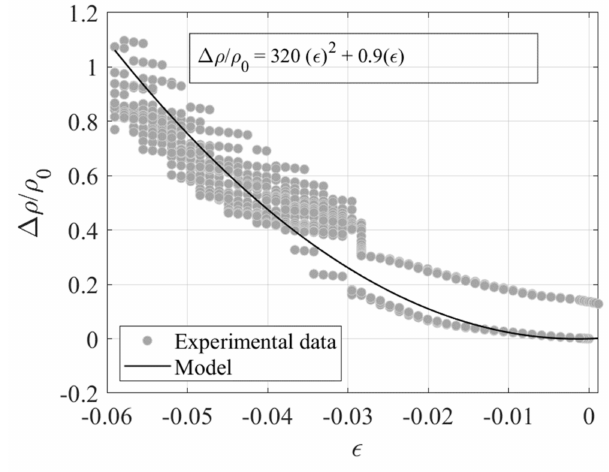
Figure 31. Variation of normalised resistivity vs compressive